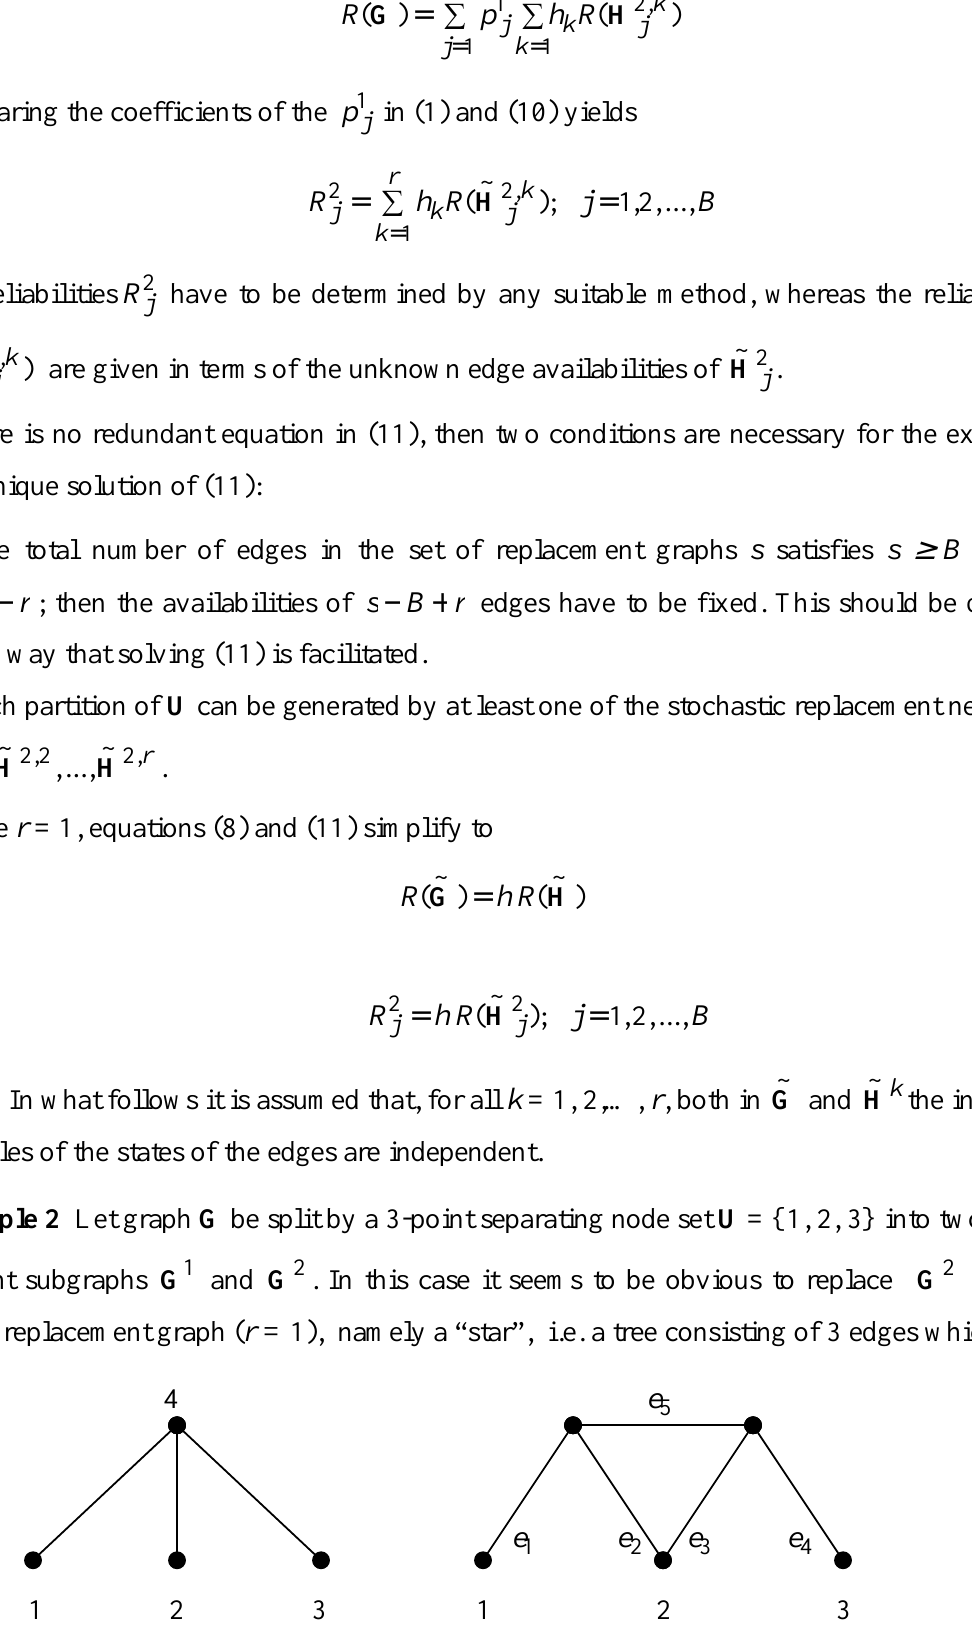
Figure 2 Replacement graph “star” Figure 3 Replacement graph in example